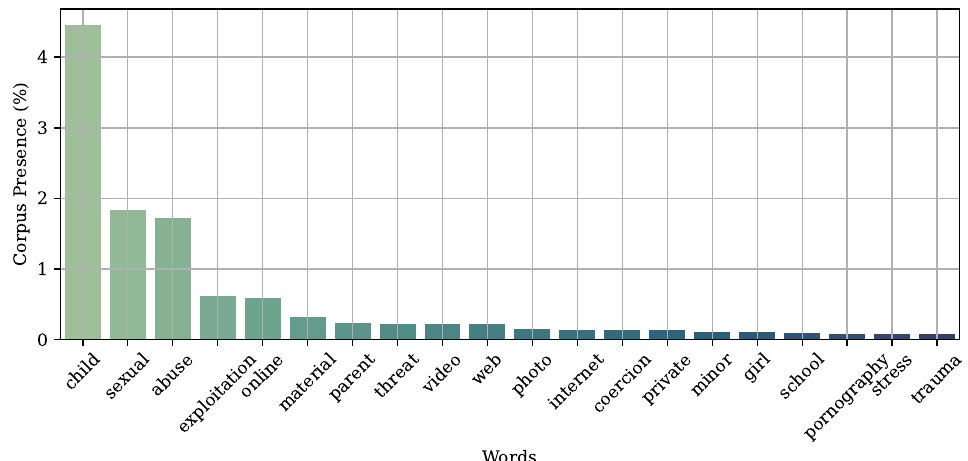
Figure 3. Top 20 of the most important keywords related to child abuse, which were used to test the capability of the ASR system to detect specific terminology within the domain.